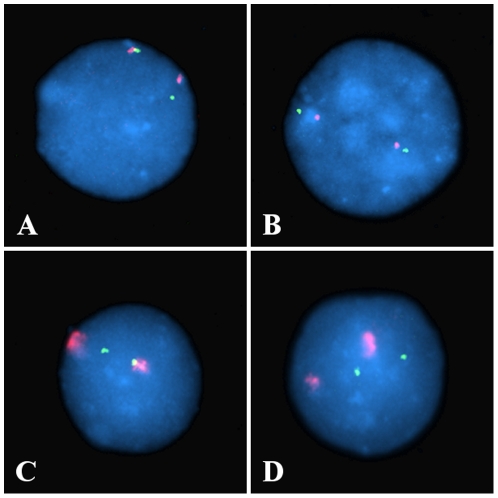
Gene-heterochromatin co-localization assessment.Co-localisation was assessed by identifying gene signals (green) showing any degree of overlap with the classical satellite DNA signal (red). The co-localisation assessment was carried out independently from the heterochromatin spatial configuration (“conventional” in A and B, and “compact” in C and D) and the intra-nuclear positioning of both gene and heterochromatic signals.